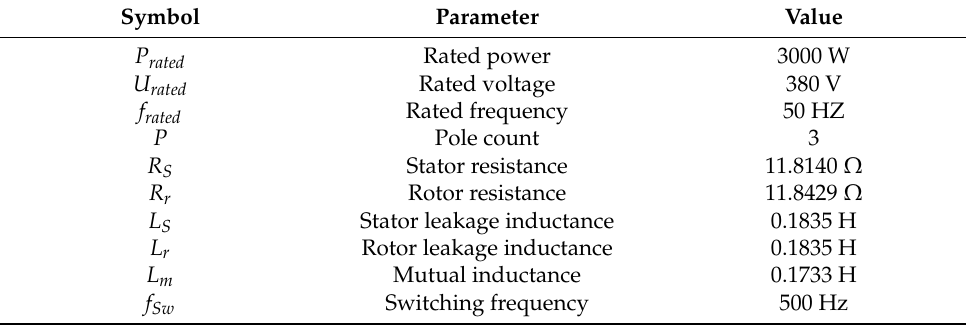
Table 1. Simulation and experimental